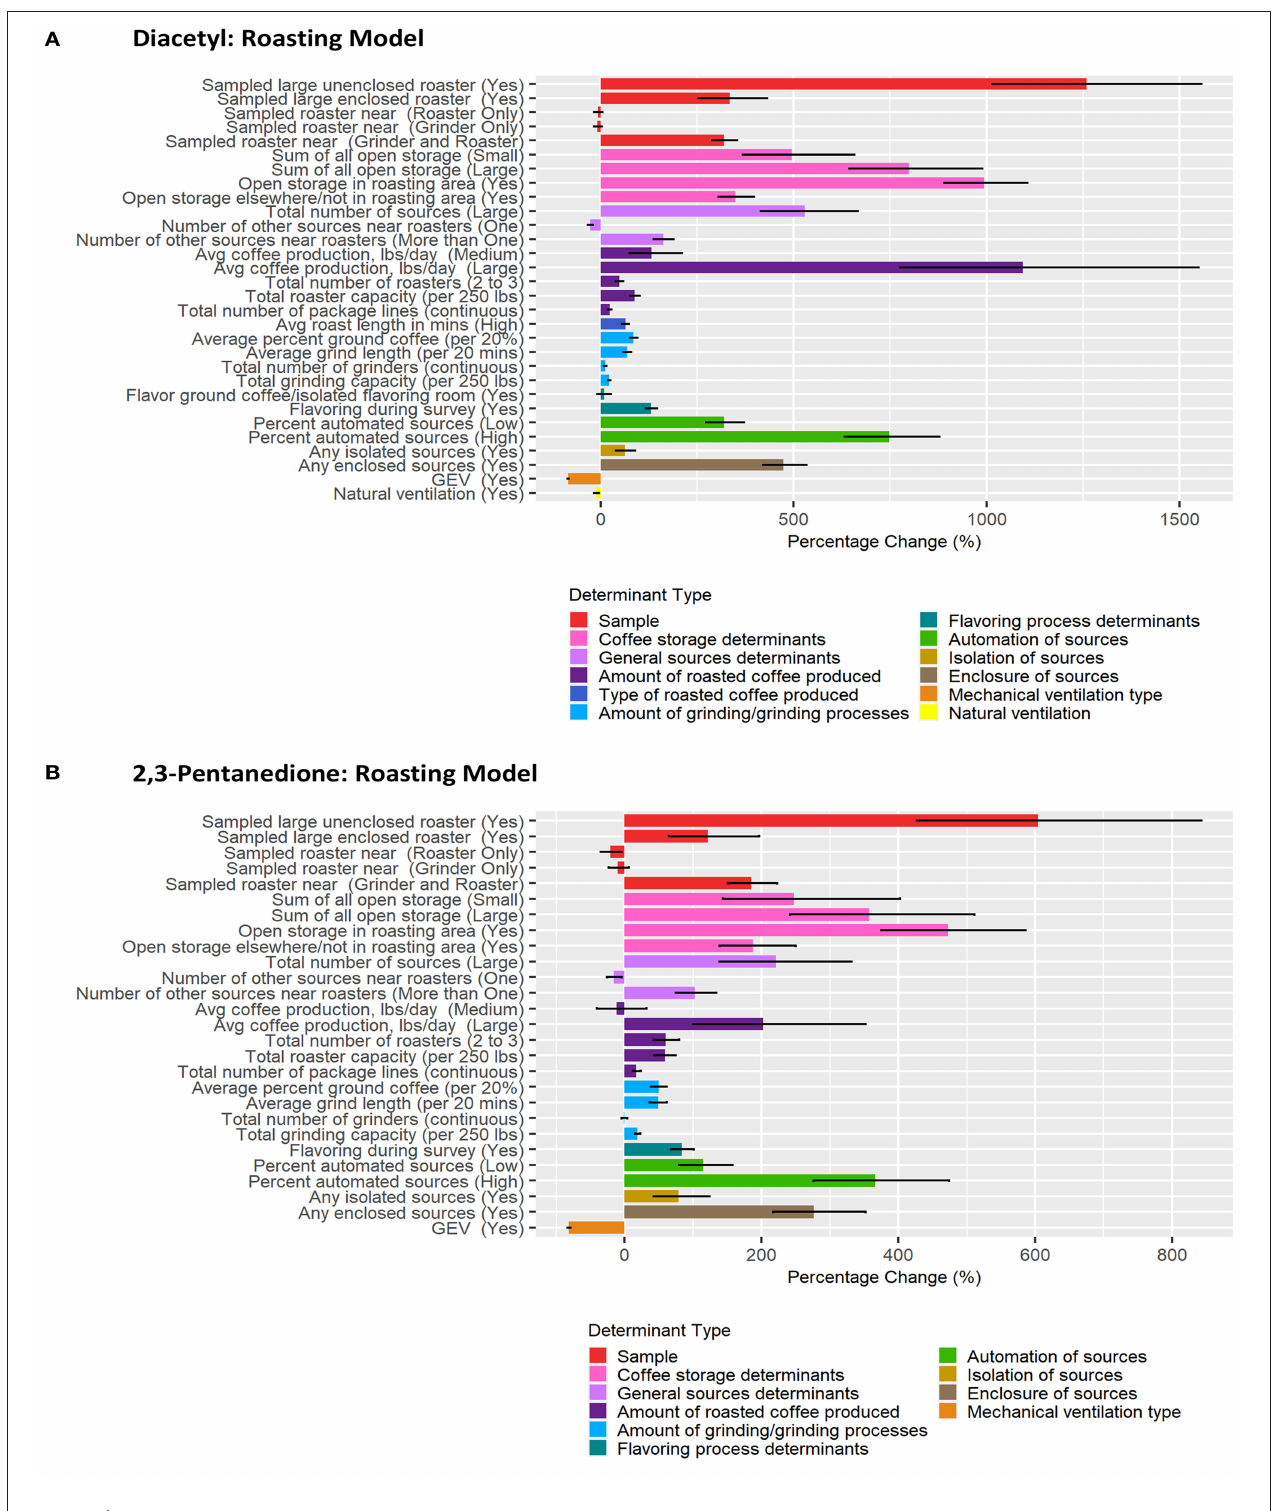
FIGURE 4 | Bar chart of percent change in diacetyl (A) and 2,3-pentanedione (B) exposures during roasting tasks compared with reference category or per unit change. Each bar represents the estimated percent change for the median posterior estimate with error bars for the 95% credible intervals. Percent change for continuous variables defined as per 1 unit with the exceptions of the following: total roaster capacity and total grinder capacity are calculated per 250 lbs, average percent ground coffee is calculated per increase in 20%, and average grind length in minutes is calculated per 20min.